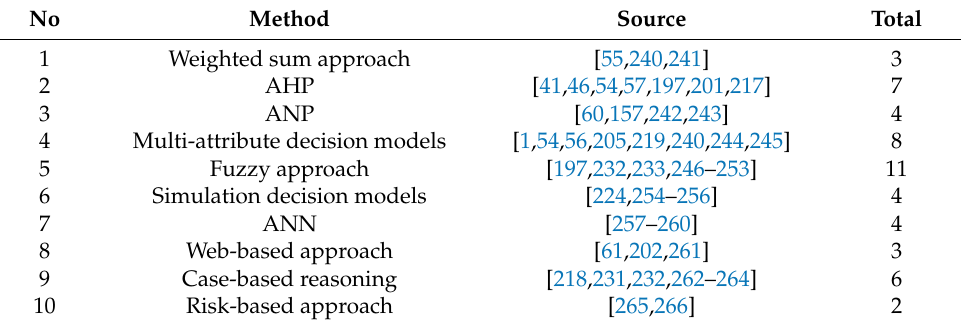
Table 3. Overview of project delivery selection